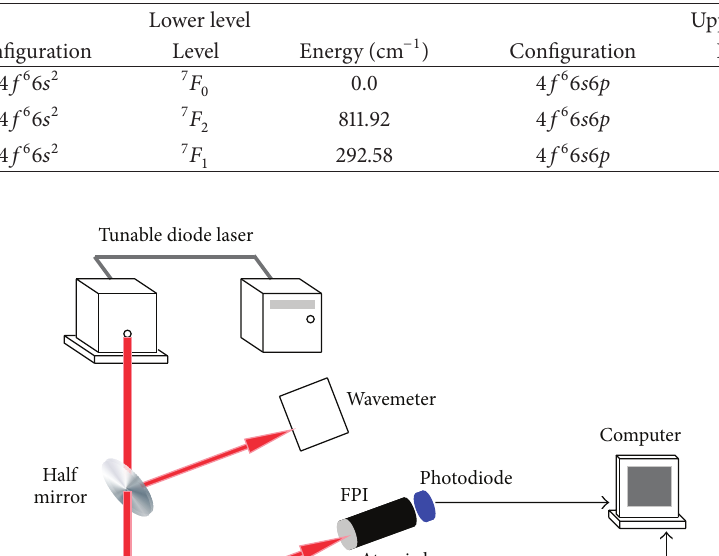
Table 1: Wavelengths of the studied transitions and properties of the lower and upper levels in Sm I.